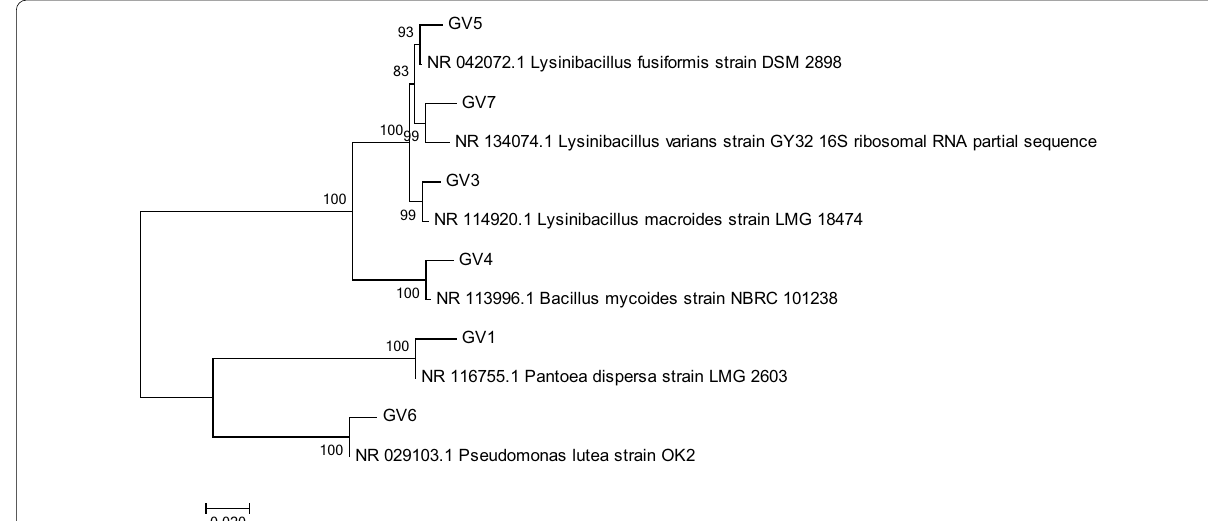
Fig. 2 Evolutionary relationships of taxa. The evolutionary history was inferred using the neighbor joining method (Saitou and Nei 1987). The optimal tree with the sum of branch length 0.45843344 is shown. The percentage of replicate trees in which the associated taxa clustered = together in the bootstrap test (1000 replicates) are shown next to the branches (Felsenstein 1985). The tree is drawn to scale, with branch lengths in the same units as those of the evolutionary distances used to infer the phylogenetic tree. The evolutionary distances were computed using the maximum composite likelihood method (Tamura et al. 2004) and are in the units of the number of base substitutions per site. The analysis involved 12 nucleotide sequences. Codon positions included were 1st 2nd 3rd Noncoding. All positions containing gaps and missing data were + + + eliminated. There were a total of 1298 positions in the final dataset. Evolutionary analyses were conducted in MEGA7 (Kumar et al. 2016)